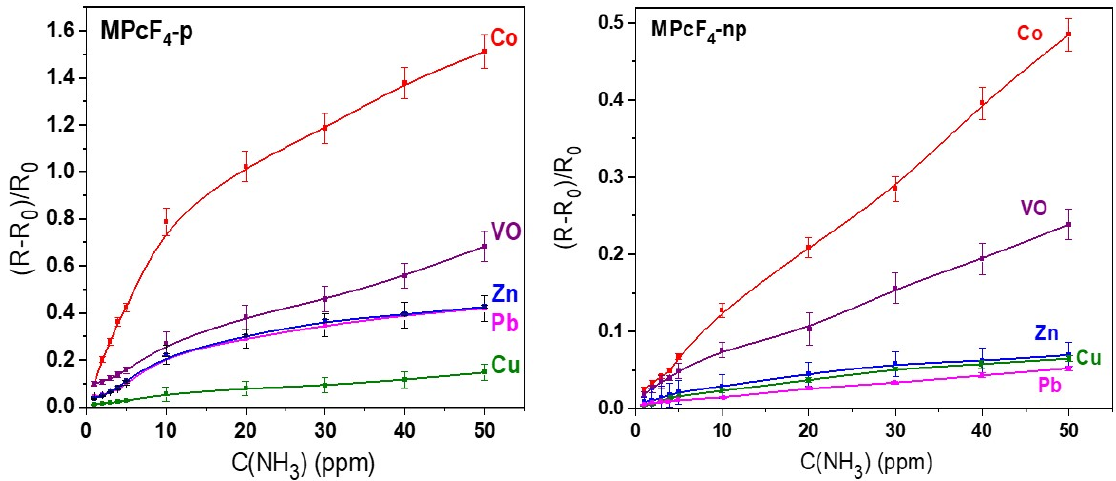
Figure 6. Dependence of the sensor response of MPcF 4 -p and MPcF 4 -np films on ammonia concen- tration (1–50 ppm), measured at room temperature.